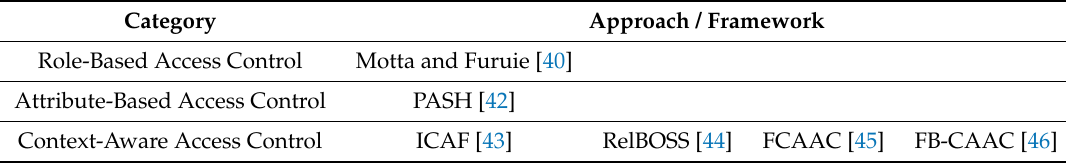
Table 1. Overview of selected access control mechanisms from the literature, categorised into Role-Based Access Control, Attribute-Based Access Control and Context-Aware Access